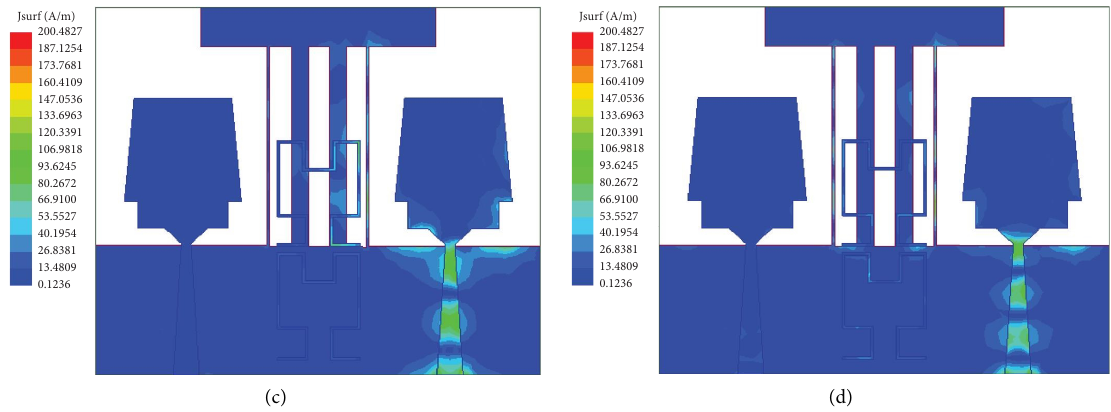
Figure 10: SWB-MIMO current distribution at diferent frequency points. (a) 2GHz. (b) 10GHz. (c) 20 GHz. (d) 30GHz.